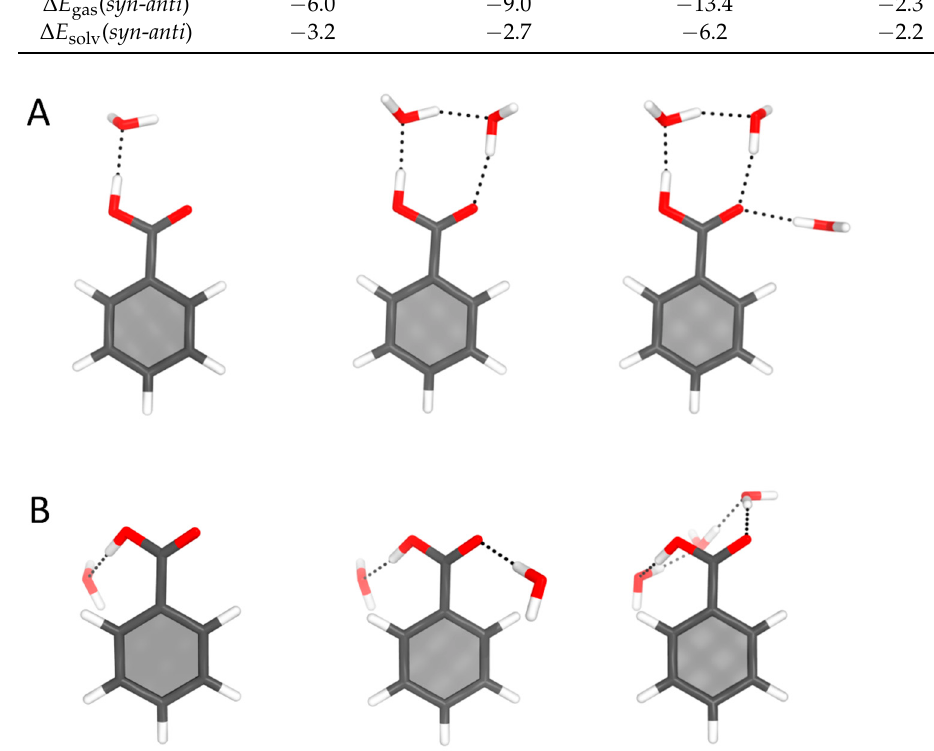
Figure 10. Microsolvated structures of syn -BA ( A ) and anti -BA ( B ) after B3LYP/def2-TZVP/D3 optimization in the implicit solvent.